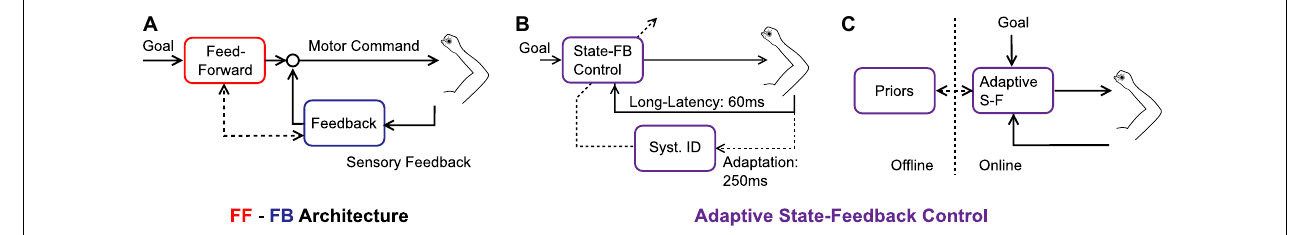
FIGURE 1 | (A) Feedforward-feedback control architecture, each pass corresponds to different neural structures that share knowledge of the environmental dynamics. Feedforward and Feedback are associated with red and blue colors, respectively. (B) Adaptive state-feedback control model in which an identification of the system parameters (Syst. ID) updates a state-feedback controller online (State-FB Control). The timescales are represented: it is assumed that state-feedback control is supported by long-latency feedback loops (timescale: ∼ 60 ms), and the online updates are associated with a slower timescale ( ∼ 250 ms). (C) Conceptual representation of the adaptive state-feedback controller which can replace feedforward and feedback mechanisms, while different time scales are associated with online and offline